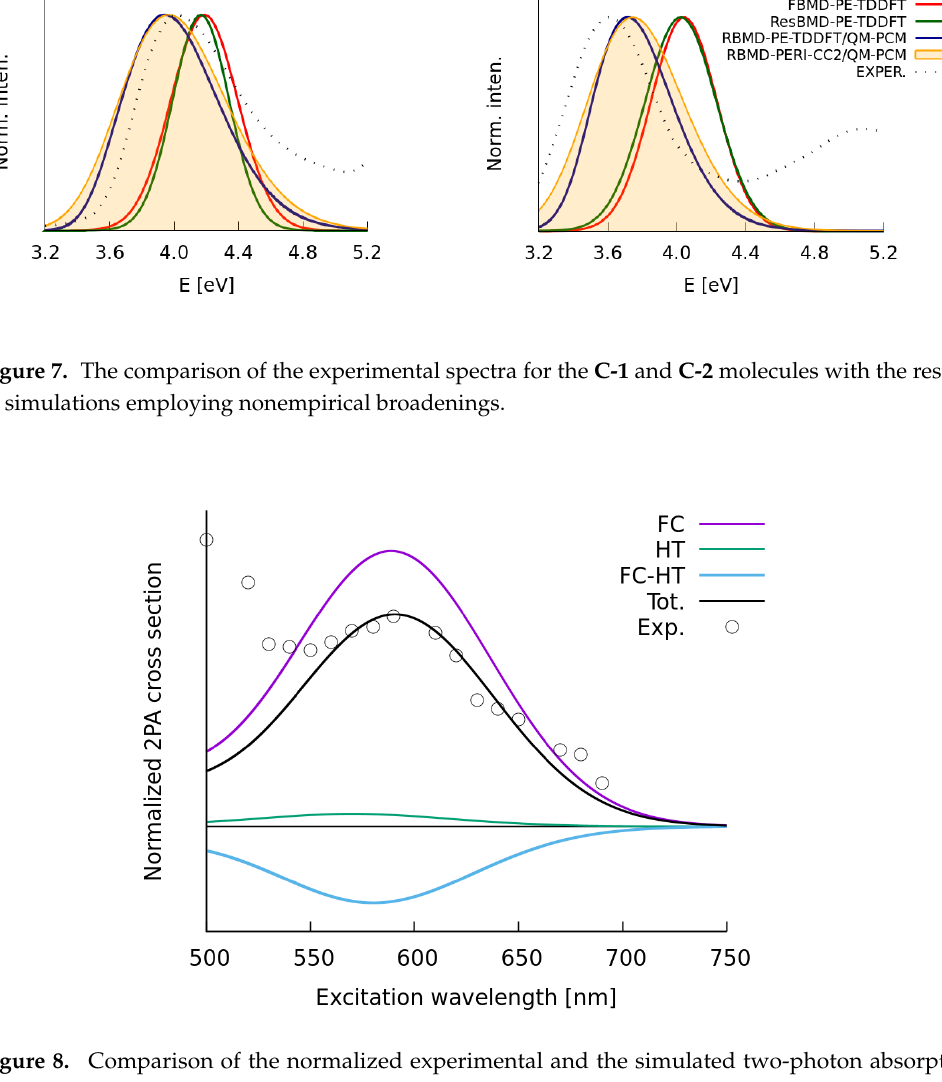
Figure 8. Comparison of the normalized experimental and the simulated two-photon absorption spectra of C-1 in methanol. Table 3. Summary of average excitation energies and broadening parameters represented by